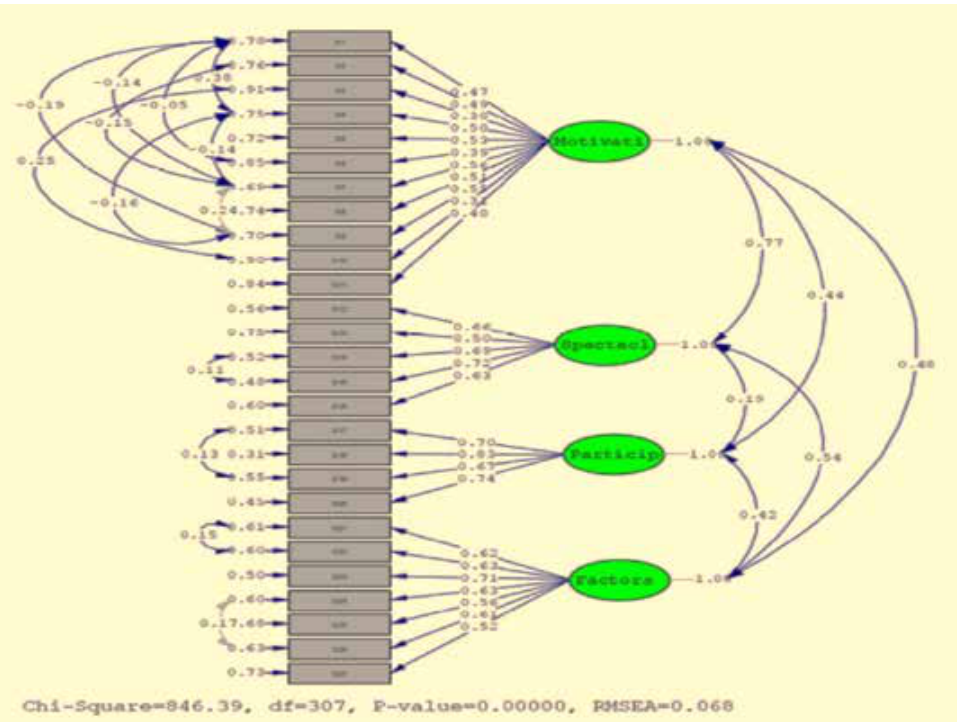
Figure 1. A confirmatory factor analysis of the main study variables with covariance coefficients between them (standardized coefficients)